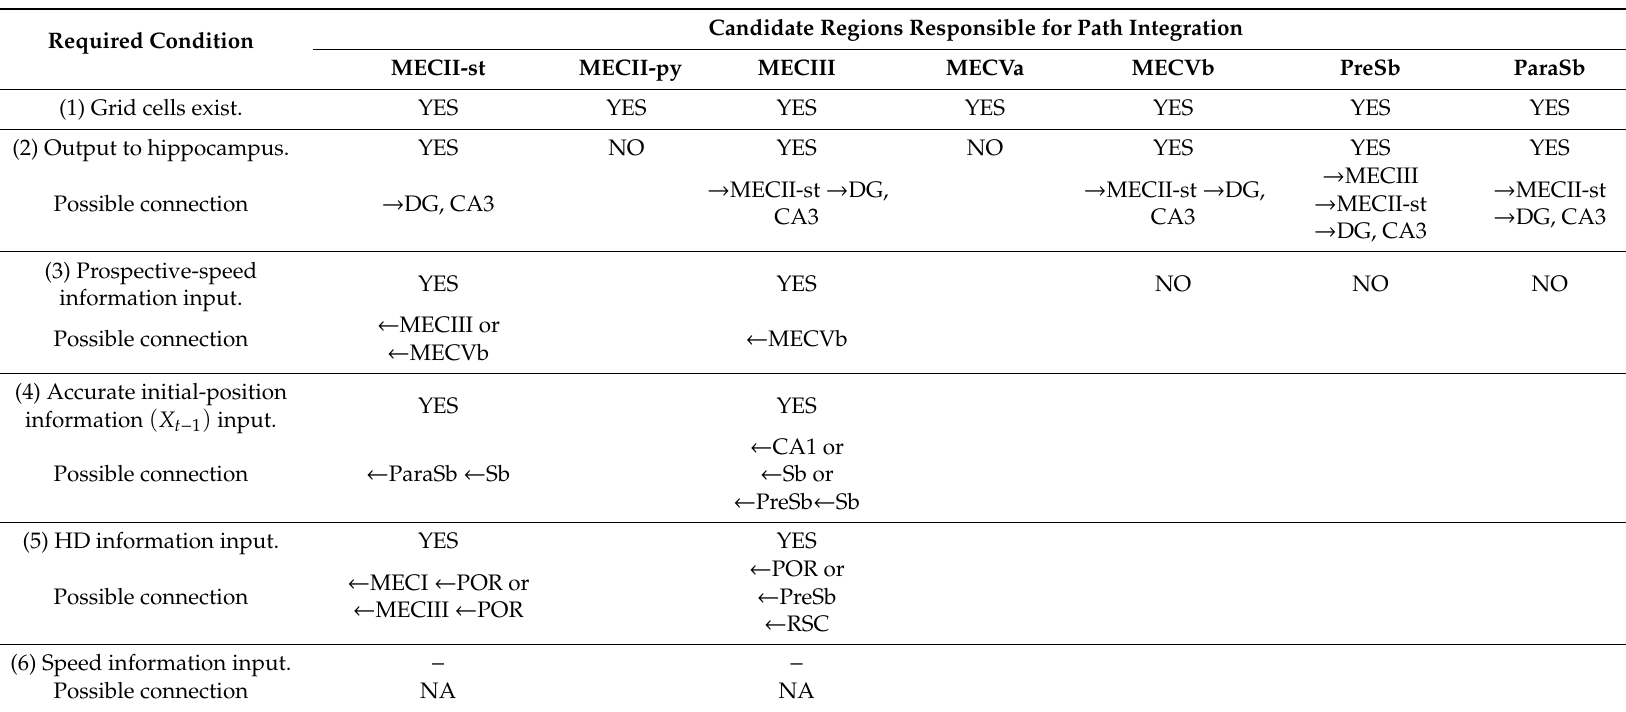
Table 4. Process of identifying regions that satisfy required conditions of path-integration